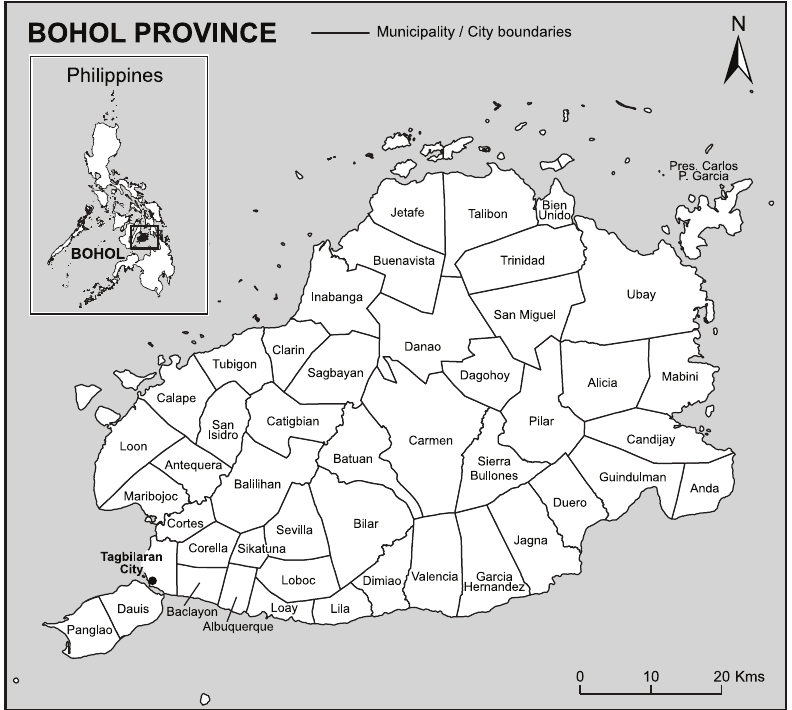
Figure 1. Map of the province of Bohol Philippines. BOHOL FACTFILE. Total Population: 1,139,130. Total Households: 152,324. Total Land Area: 11,726 hectares. 47 municipalities, 1 city & 1,109 barangays or villages. 81 offshore islands & islets. 30 coastal municipalities and 304 coastal barangays. Annual per capita income: 16,478 PHP (378 US $ ). Annual per capita expenditure: 14,364 PHP (378 US $ ). Annual average family income: 77,291 PHP (1,770 US $ ). Annual average family expenditure: 66,907 PHP (1,534 US $ ). PHP=Philippine